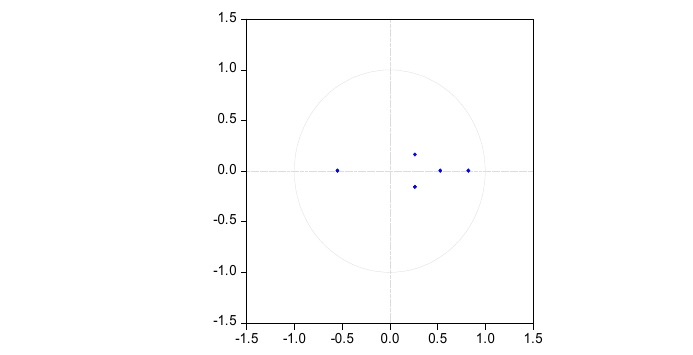
Figure 4. VAR roots of characteristic polynomial of extraction of petroleum and natural gas. Note: blue dots indicate characteristic roots. Figure 5. VAR roots of characteristic polynomial of mining and processing of non-ferrous metal ores. Note: blue dots indicate characteristic roots. Figure 6. VAR roots of characteristic polynomial of mining and processing of ferrous metal ores. Note: blue dots indicate characteristic roots.